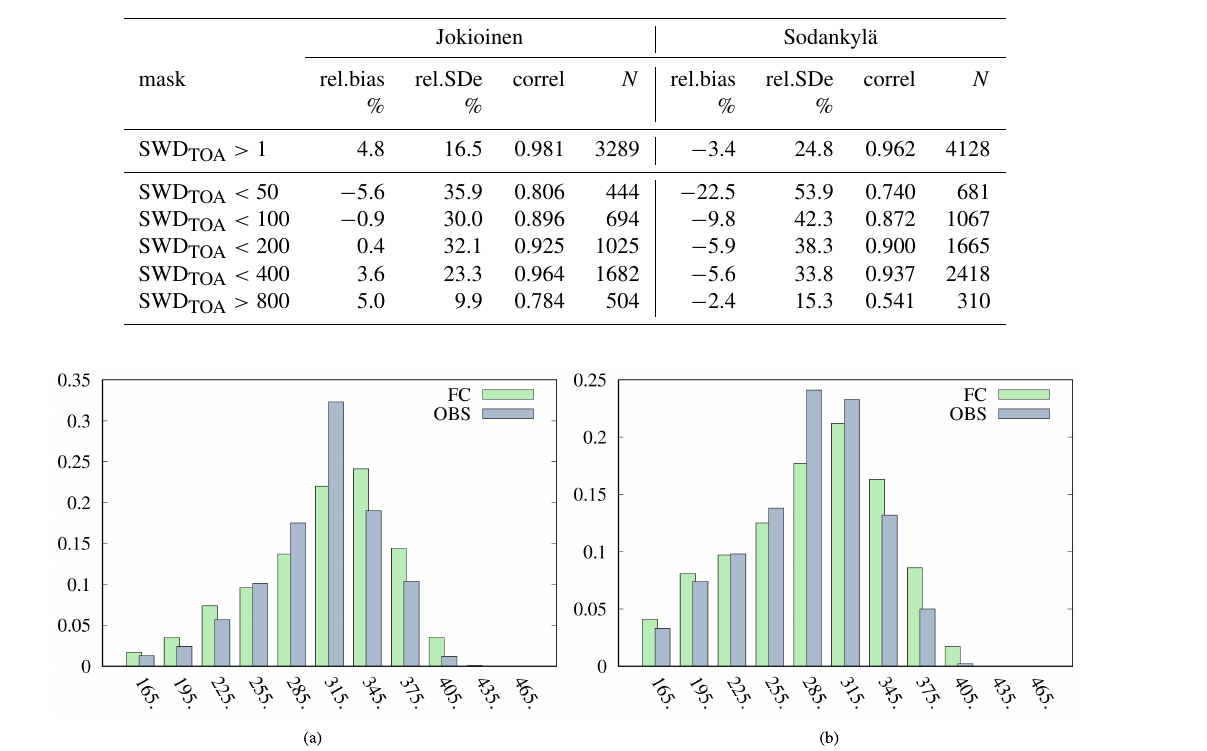
Figure 7. Observed (grey) and forecast (green) LWDS distribution over all available data: (a) Jokioinen (b) Sodankylä. Units on x -axis: Wm − 2 , on y -axis: relative frequency